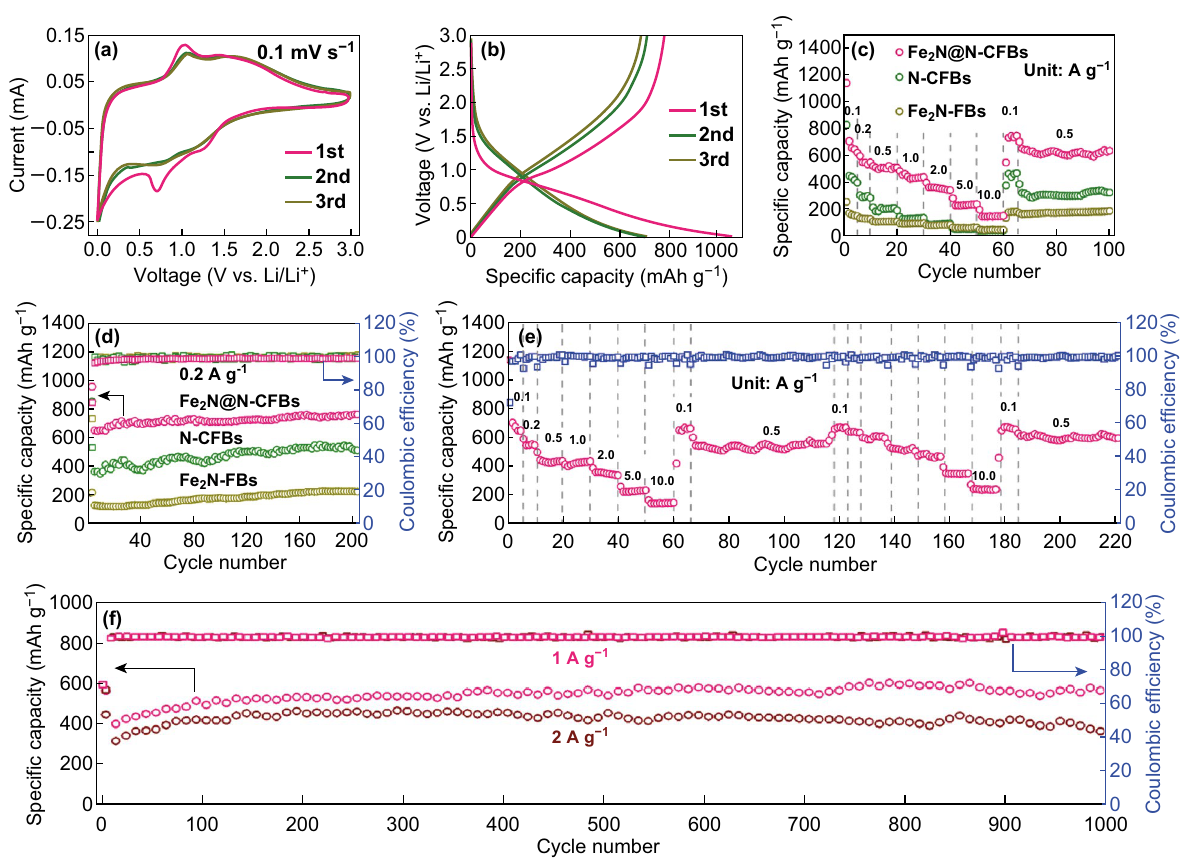
Fig. 4 Lithium-ion storage properties of Fe 2 N@N-CFBs. a CV curves and b discharge–charge voltage profiles of Fe 2 N@N-CFBs for the first three cycles. c Cycling performances and d rate capacities of Fe 2 N@N-CFBs, N-CFBs, and Fe 2 N-FBs. e Repeated rate and cycling tests and f long-term cycling performance of Fe 2